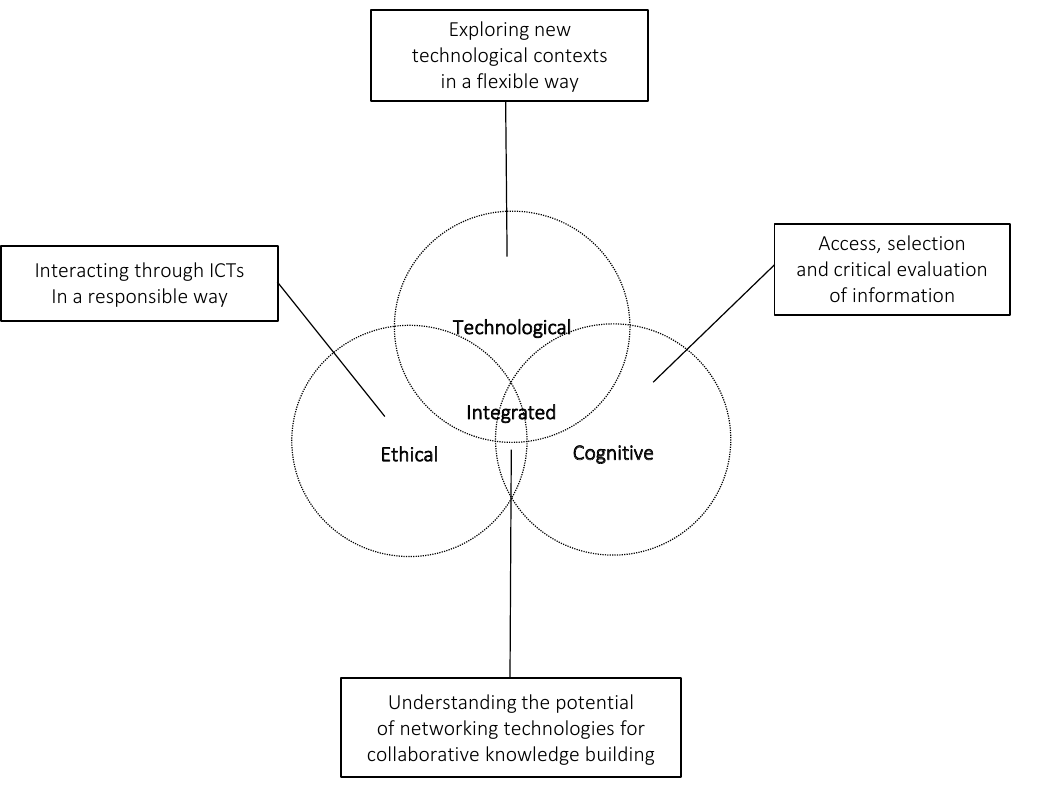
Figure 1. Intersecting areas of digital